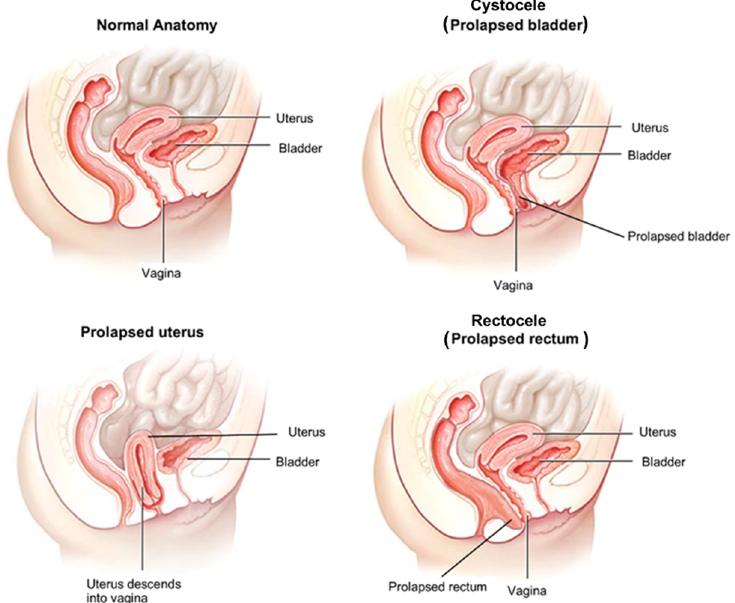
Figure 1. Pelvic organ prolapse. Pelvic organ prolapse (POP) is a multifactorial condition caused by damage to the supportive structures of the pelvic floor. Cystocele (bladder prolapse) is the most common type of prolapse and results in problems during micturition. The bladder’s supportive tissue stretches and sinks against the anterior vaginal wall. Uterine prolapse is a result of the descent of the uterus into the vagina due to the stretches during vaginal delivery and pregnancy. The weight of the uterus may cause prolapse of the other organs. Rectocele (prolapsed rectum) causes a bulge or tear (in severe cases) in the posterior vaginal wall due to the weakening of the tissue.